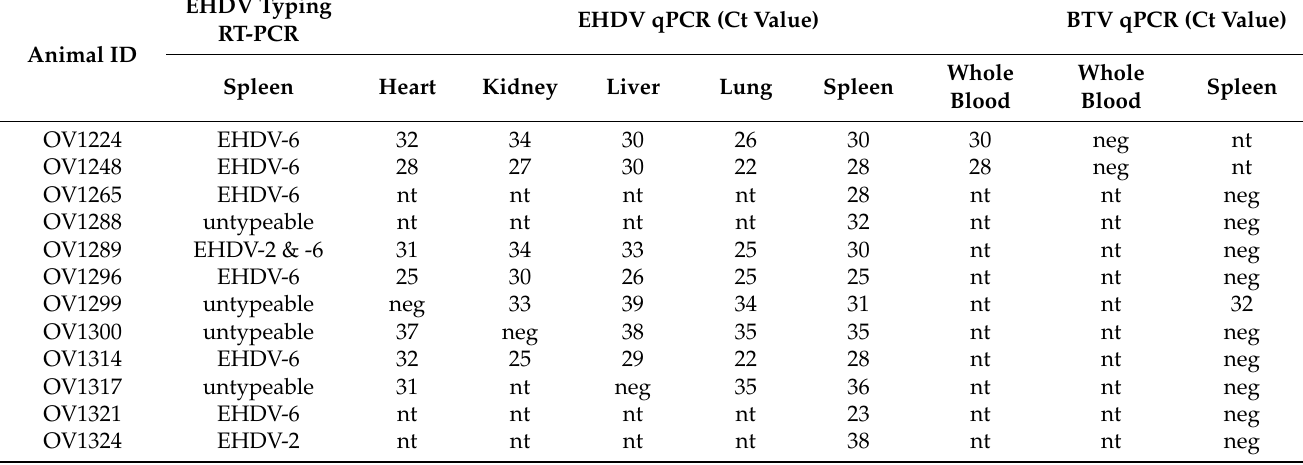
Table 3. Results of the RT-PCR and RT-qPCR testing for EHDV and BTV in tissues and whole blood taken from 12 farmed white-tailed deer, Florida,